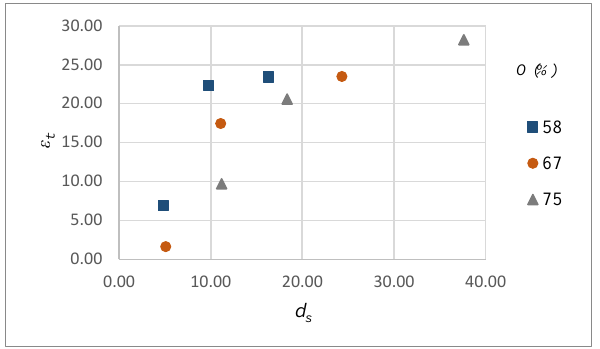
Figure 13. Correlation between d s and ε t at different pulse overlaps ( O ).